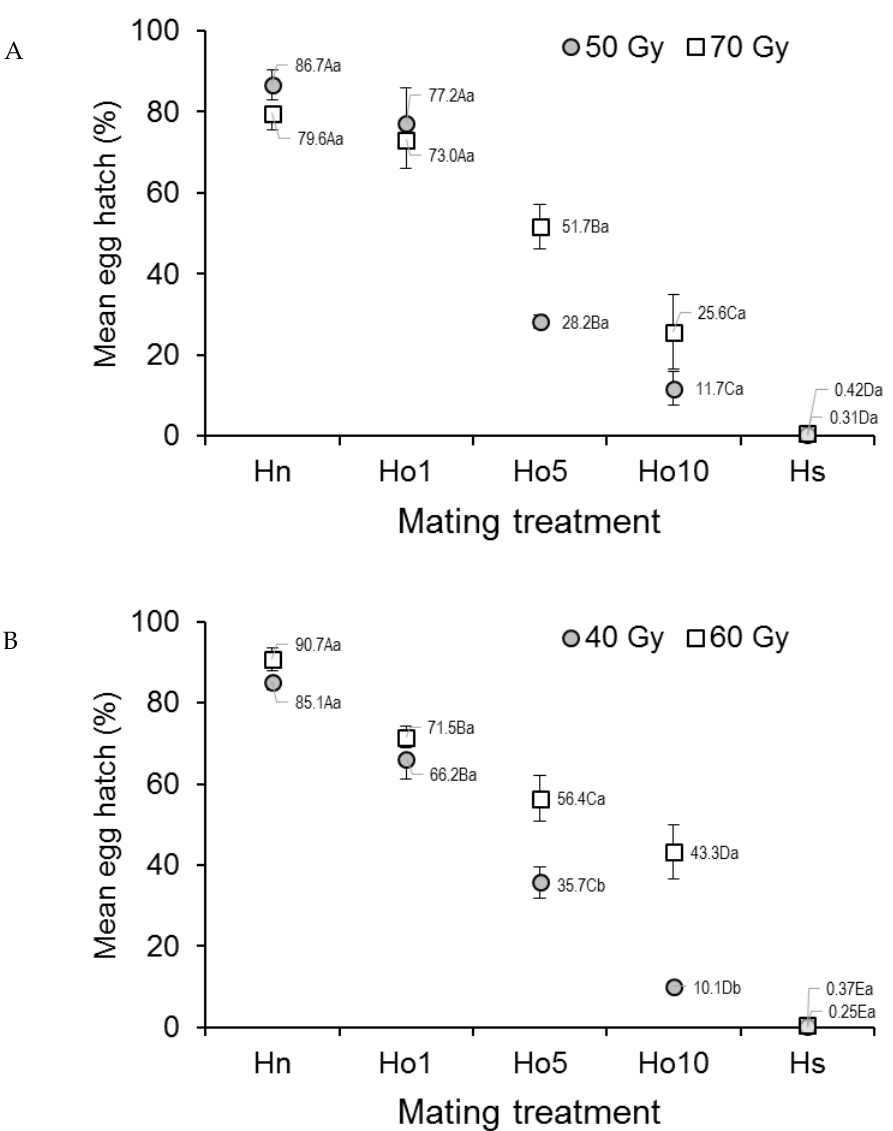
Figure 3. Prevalence (%) of hatching in eggs from ( A ) Aedes aegypti and ( B ) Aedes albopictus females that mated in field cages under different mating treatments. Males were previously exposed to one of two different irradiation doses in the pupal stage. Controls included only fertile males (Hn) and only irradiated males (Hs). Values next to points indicate mean percentages. Means followed by identical letters did not differ significantly for comparisons among mating treatments of the same dose (upper case) and for comparisons of doses within the same mating treatment (lower case) (ANOVA, Tukey p > 0.05). Vertical bars indicate the standard error. For clarity, only half the error bar is shown in some cases.